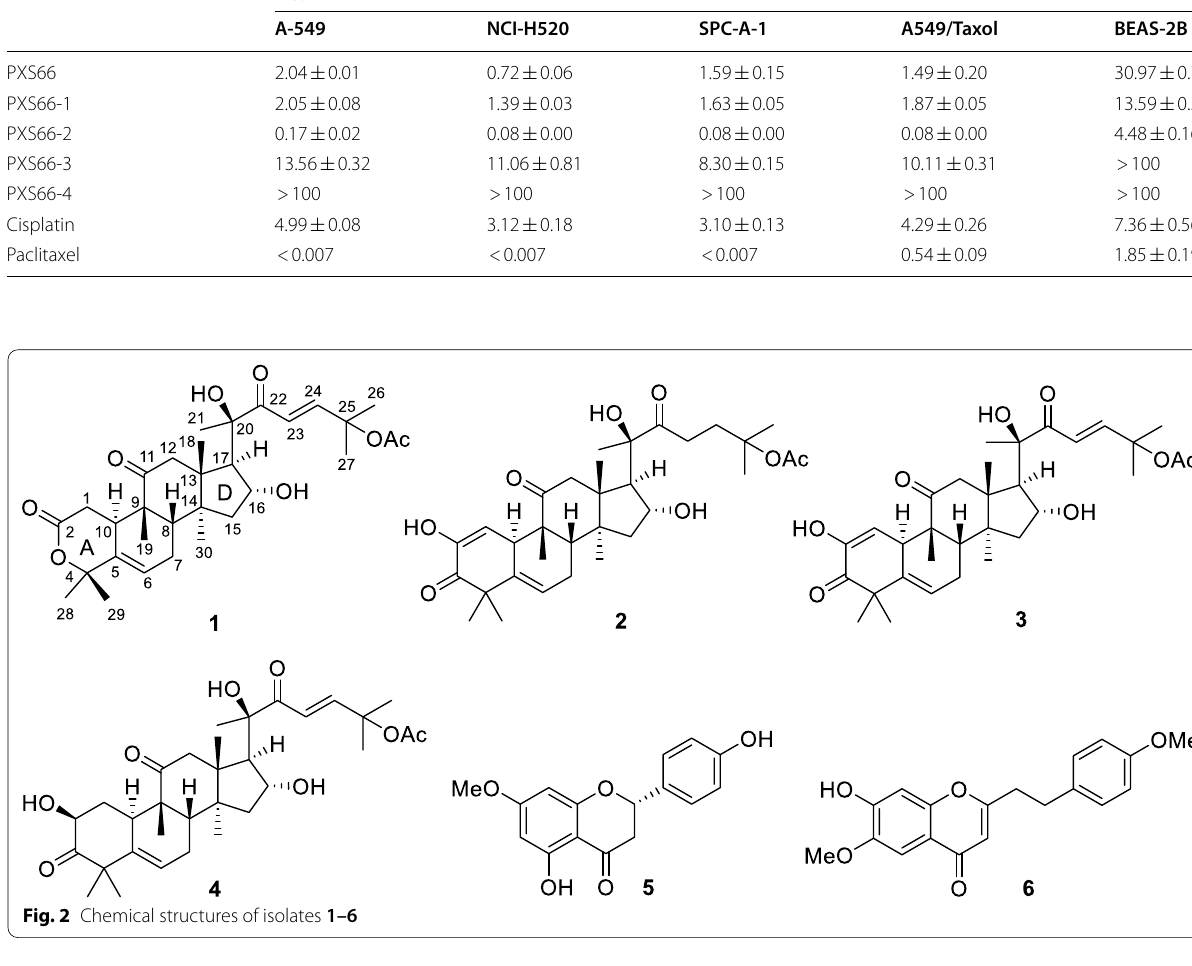
Table 3 Cytotoxicity of the subfractions from the